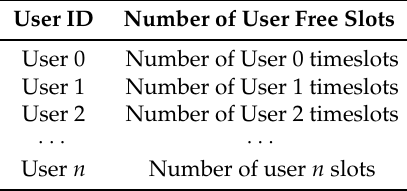
Table 2. Free allocation